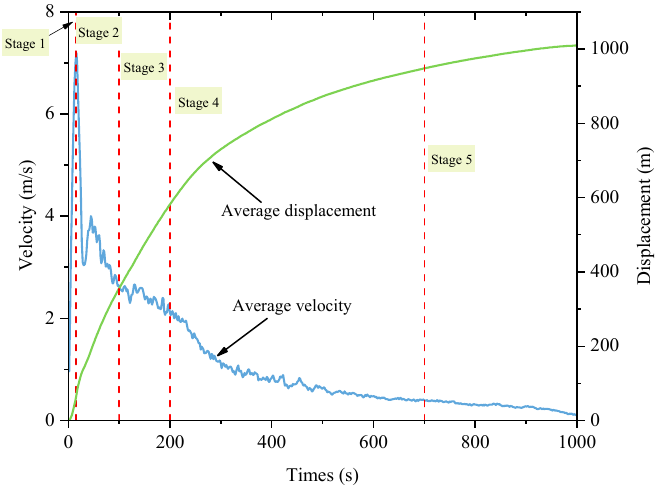
Figure 13. Average velocity and displacement evolution during different stages.